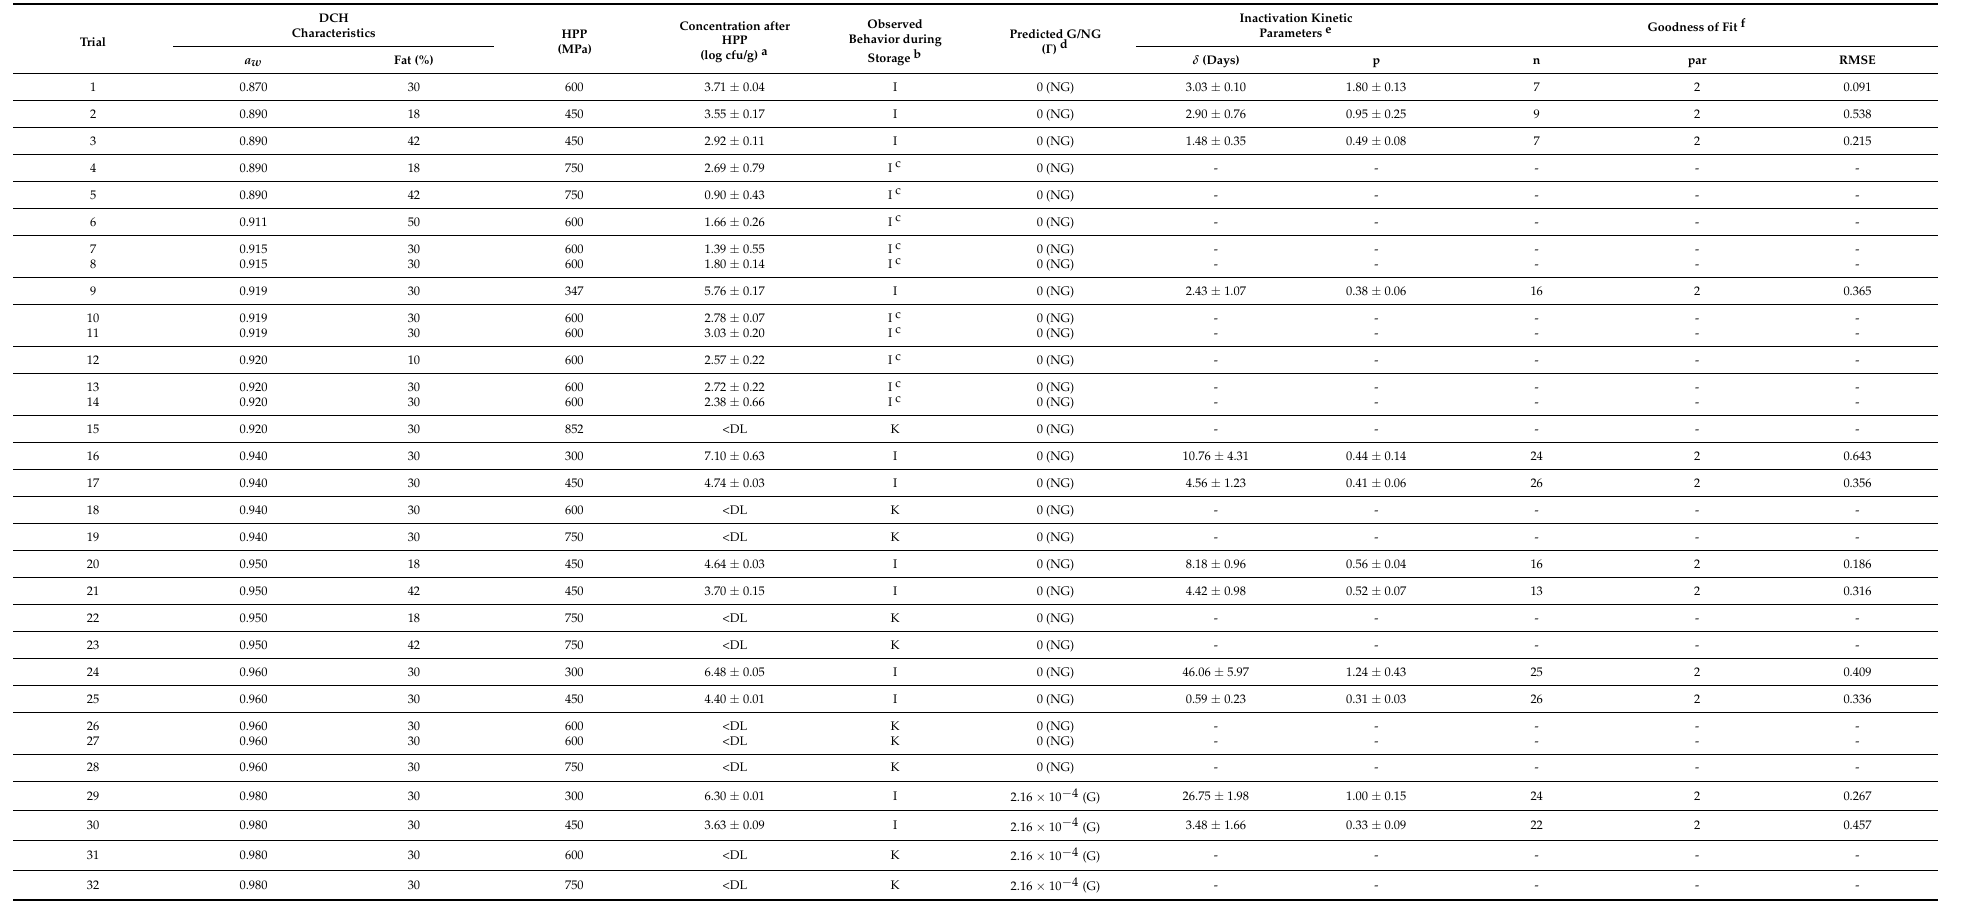
Table 1. Salmonella concentration immediately after high pressure processing (HPP) in the different trials and estimated kinetic-parameter values resulting from fitting the primary inactivation model to the Salmonella inactivation counts observed during the storage of pressurized dry-cured ham (DCH) at 7 ◦